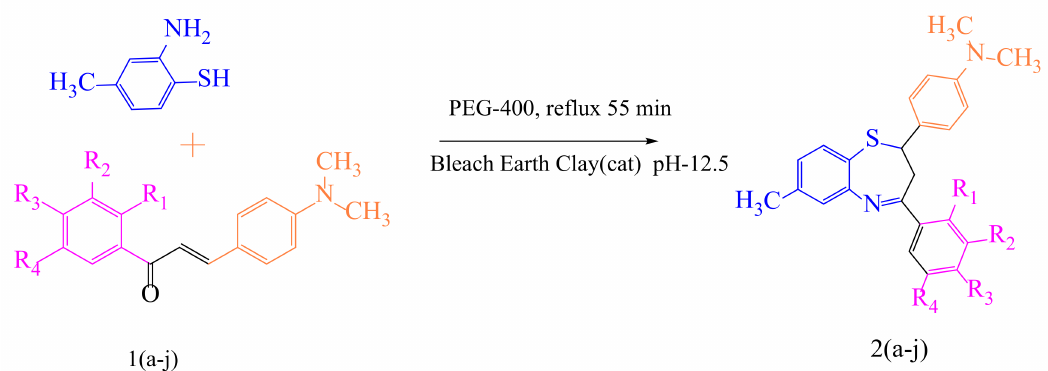
Figure 9. Scheme of 1,5-benzothiazepine derivatives in the catalytic mechanisms of PEG-400 mediated